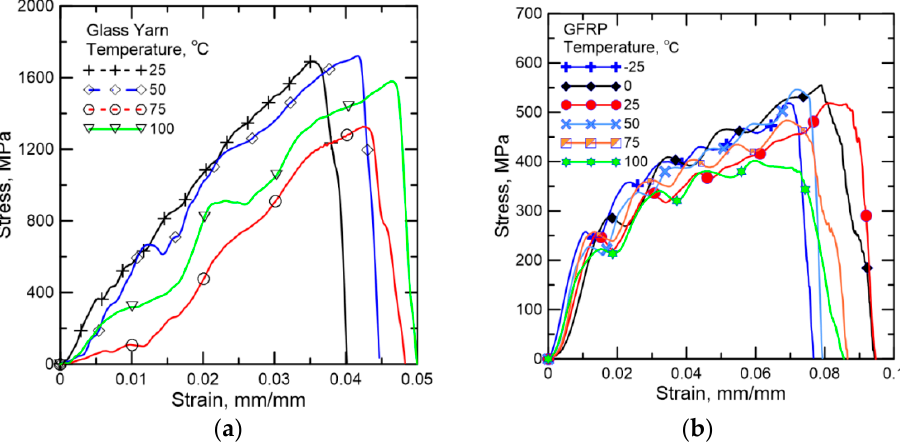
Figure 10. Representative stress–strain responses of ( a ) glass yarn at temperatures of 25, 50, 75, 100 °C and ( b ) GFRP at temperatures of − 25, 0, 25, 50, 75, 100 °C.